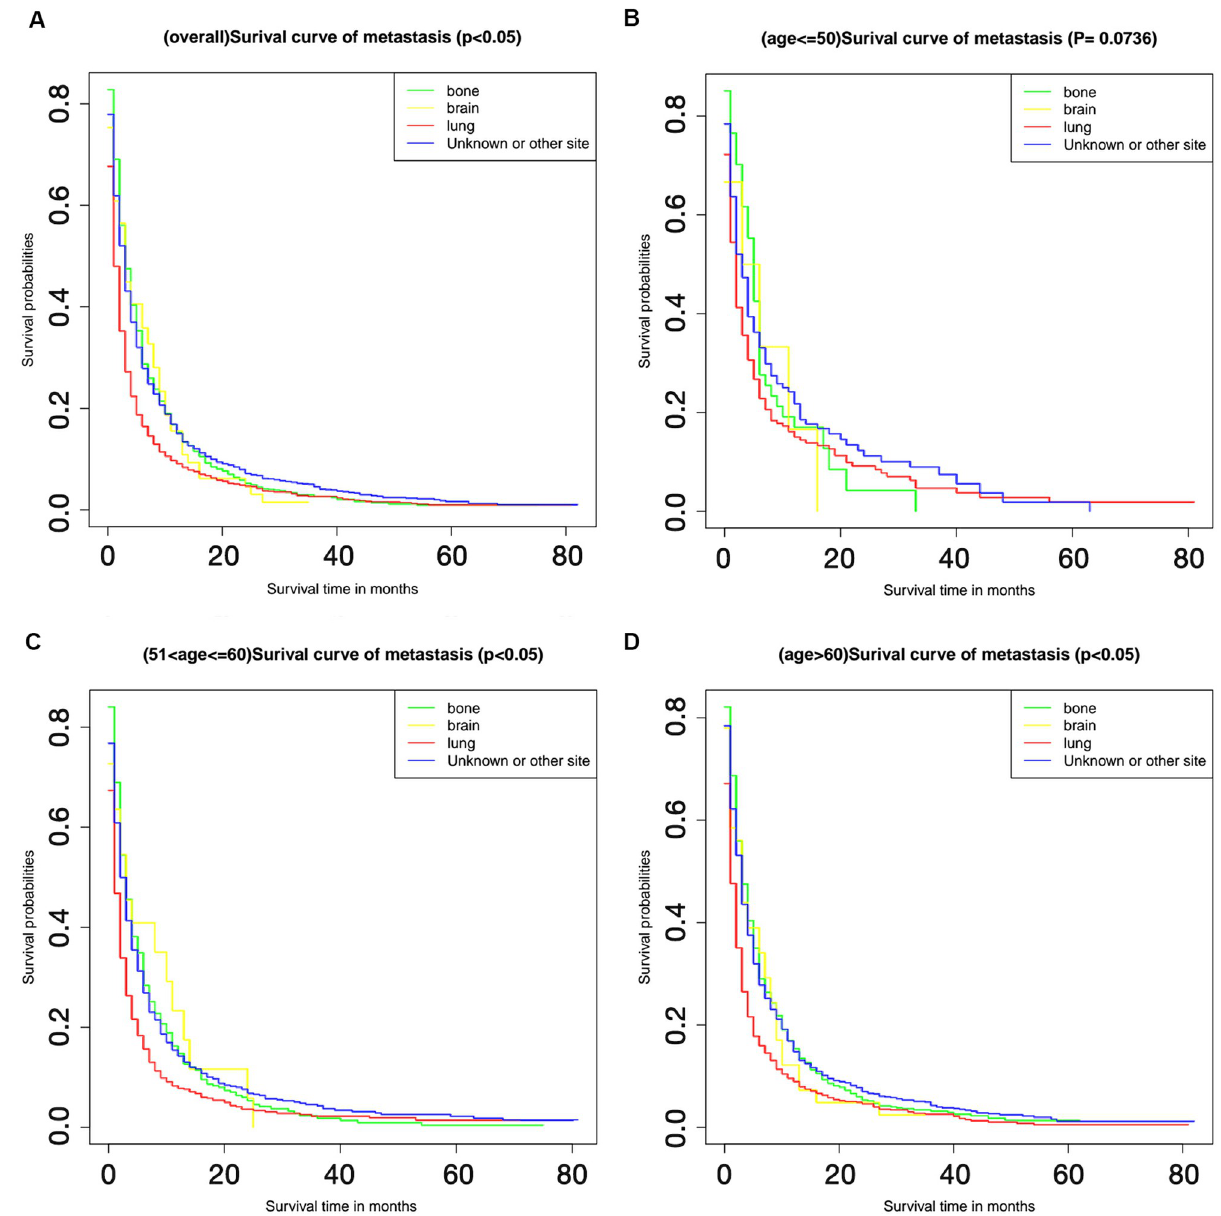
Fig 5. Kaplan-Meier curves for different age groups. The Kaplan-Meier survival curves show the differences on survival probabilities among bone metastasis, brain metastasis, lung metastasis and unknown metastasis site for all patients (A), patients < 50 years (B), patients in 50–59 years (C) and patients � 60 years